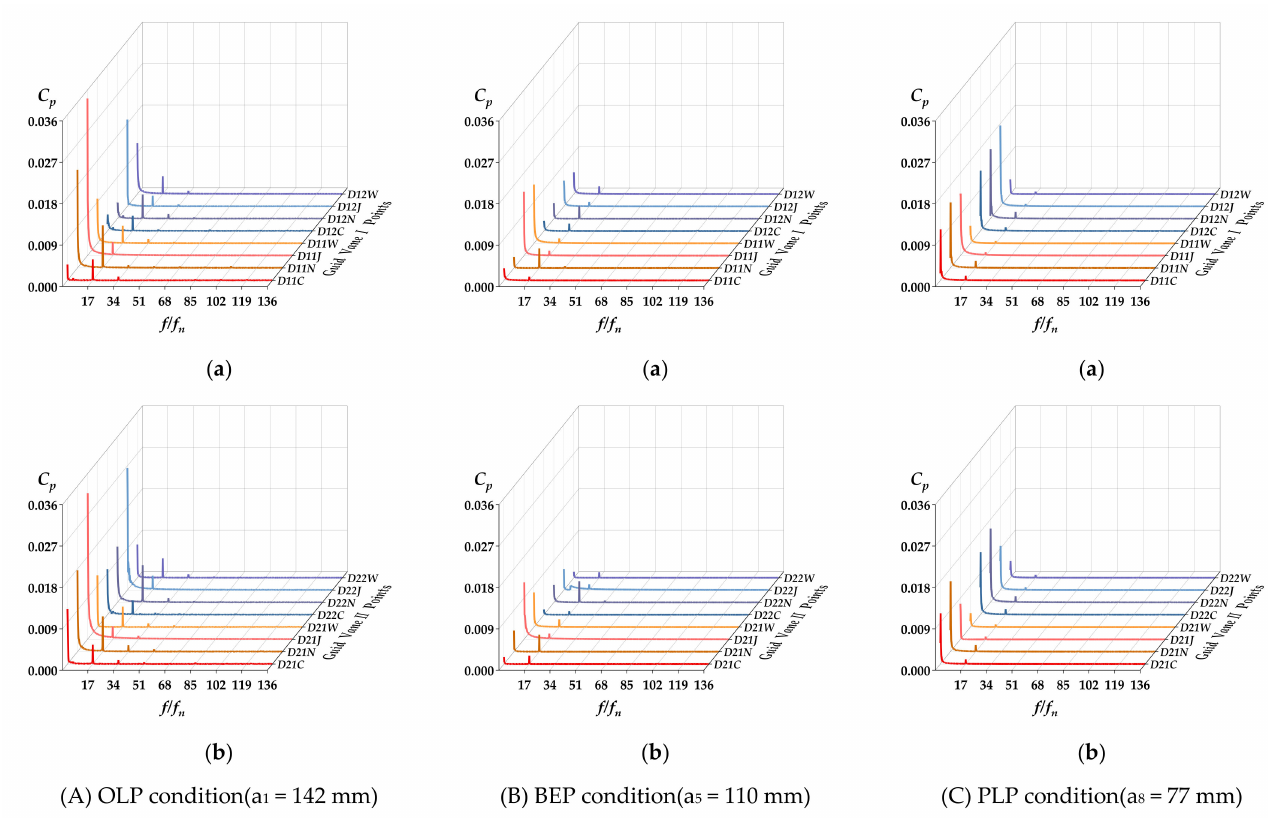
Figure 17. Spectrum of pressure pulsation at guide vane monitoring points under different working conditions. ( a ) Data from guide vane of the runner I side; ( b ) Data from guide vane of the runner II